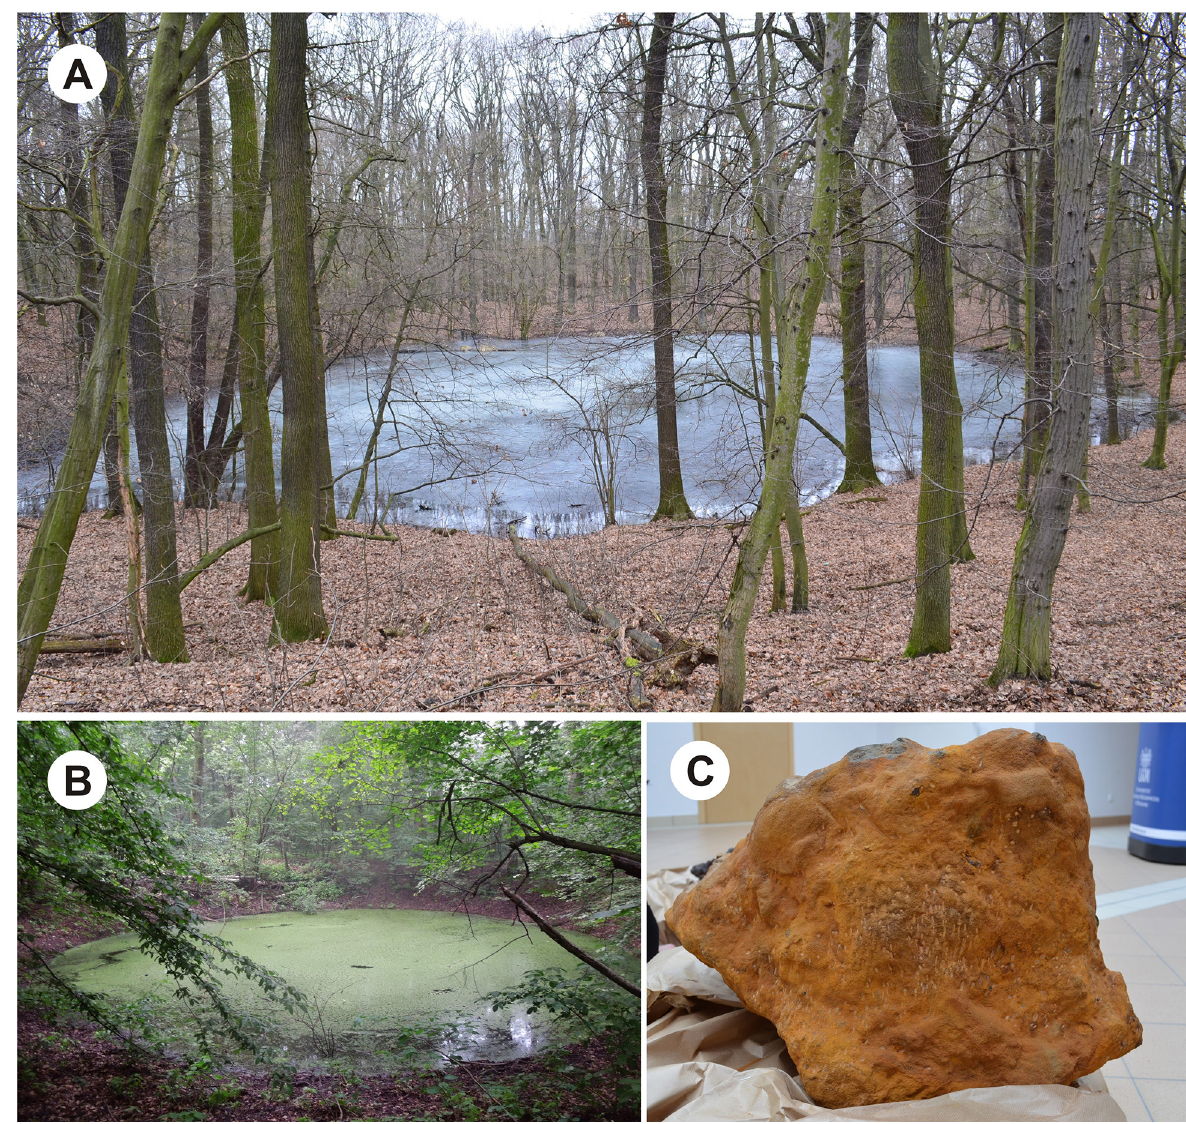
Fig. 8. Urban geosite of the Impact Crater Morasko (Photo: M. Makohonienko). A – the biggest crater A filled with water surrounded by a protected oak-horn forest (March 2013), B – crater C filled with water (July 2012), C – the largest fragment of Morasko meteorite weighing 261 kg; specimen before cleaning weighing over 300 kg (october 2012).